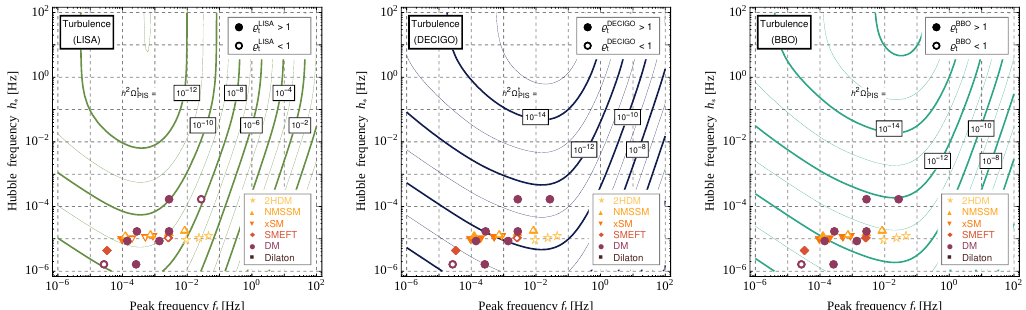
Figure 6 . PISCs for LISA, DECIGO, and BBO in the t-channel as functions of f t and h ∗ . See